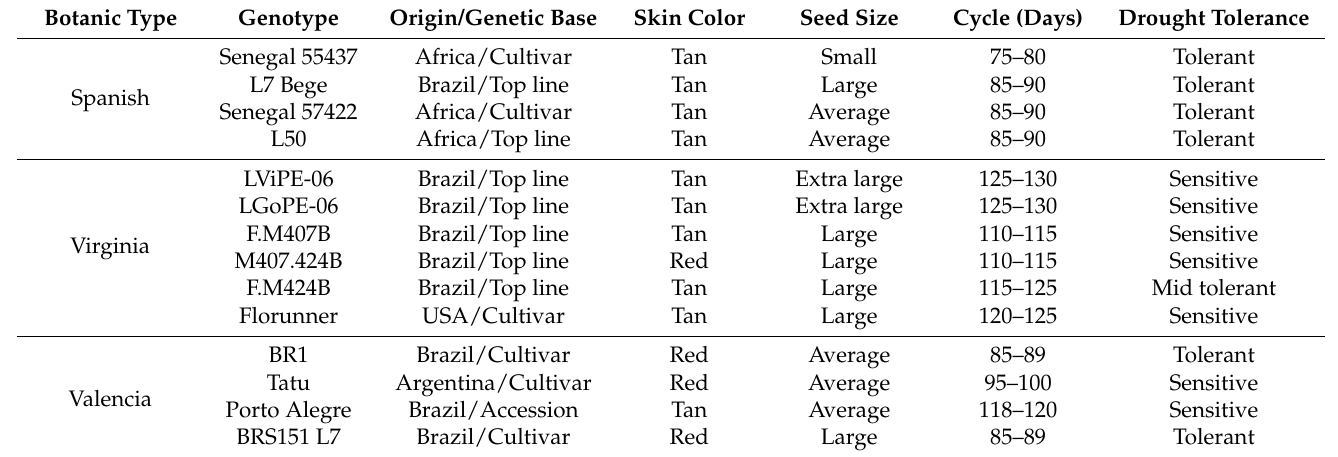
Table 1. Traits of peanut germplasm and inheritance to drought